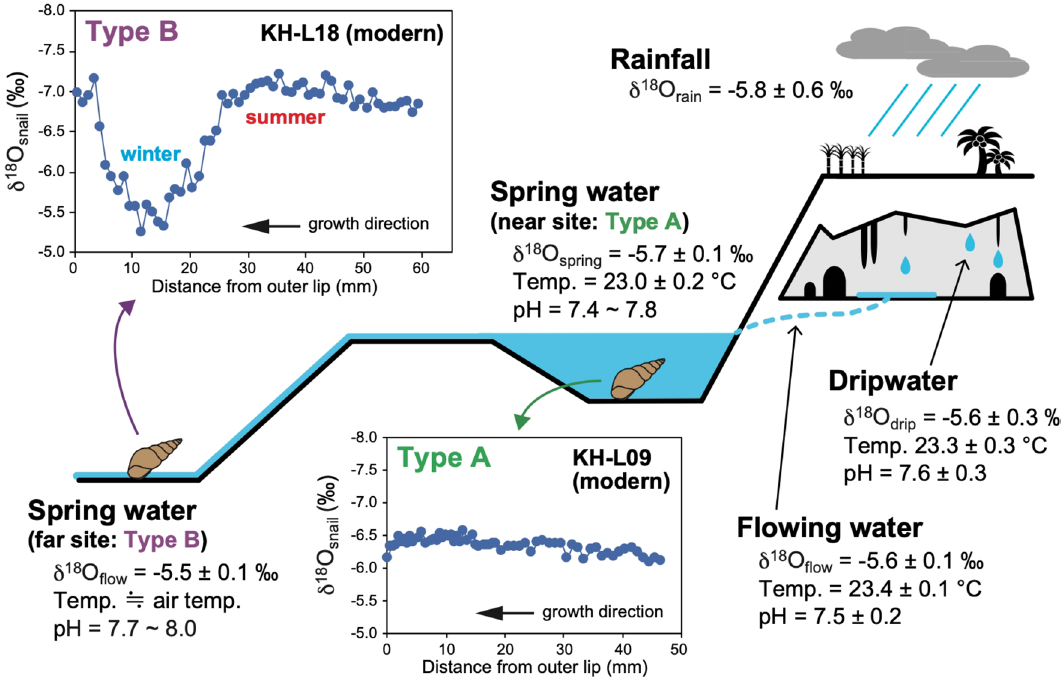
Figure 1. Schematic illustration showing a water system comprising rainfall 27 , drip water 21 , and flowing water (this study) in Gyokusen Cave, and spring water (this study) at Kakinohana near the cave. At a nearby site (Type A) and a far site (Type B) from the spring, representative δ 18 O profiles were generated from modern freshwater snails living completely in water and very shallow water,